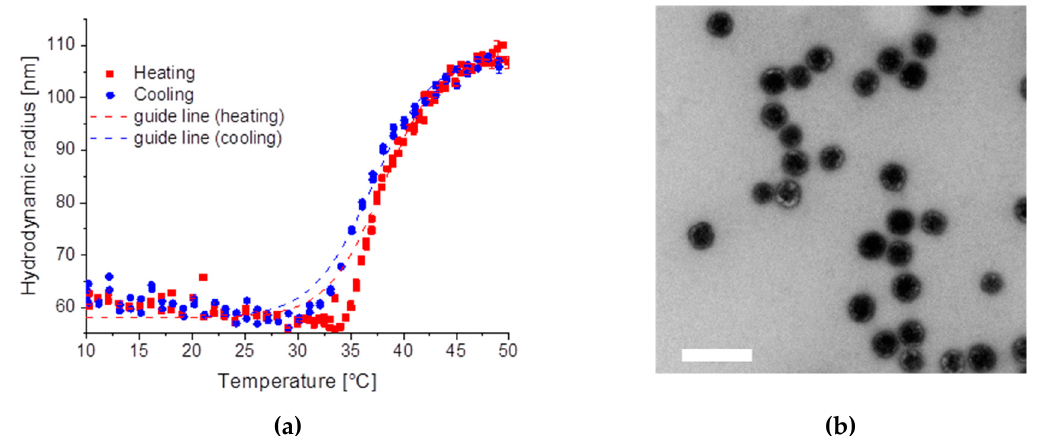
Figure 4. ( a ) Hydrodynamic radius of SiPN-2 as a function of temperature for heating and cooling; ( b ) TEmicrograph of SiPN-2. Scale bar is 200 nm.